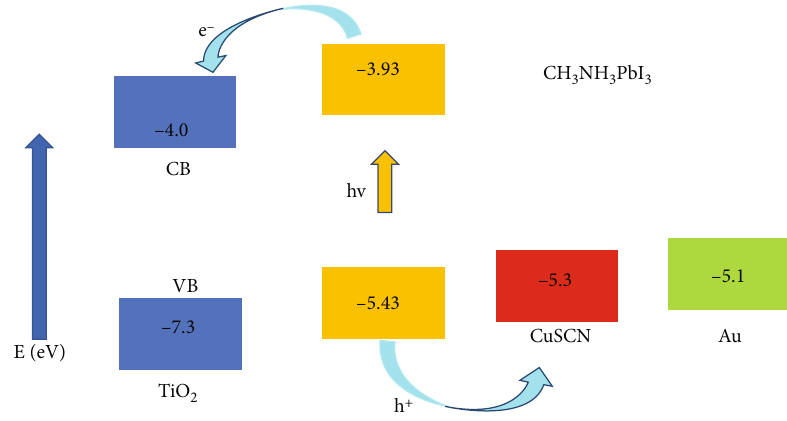
Figure 7: Schematic energy level diagram of TiO